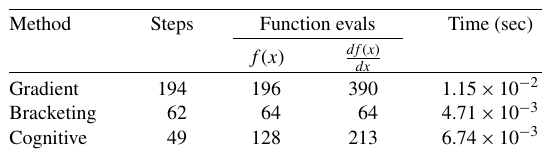
Table 1 Bracket, gradient, and cognitive search performance